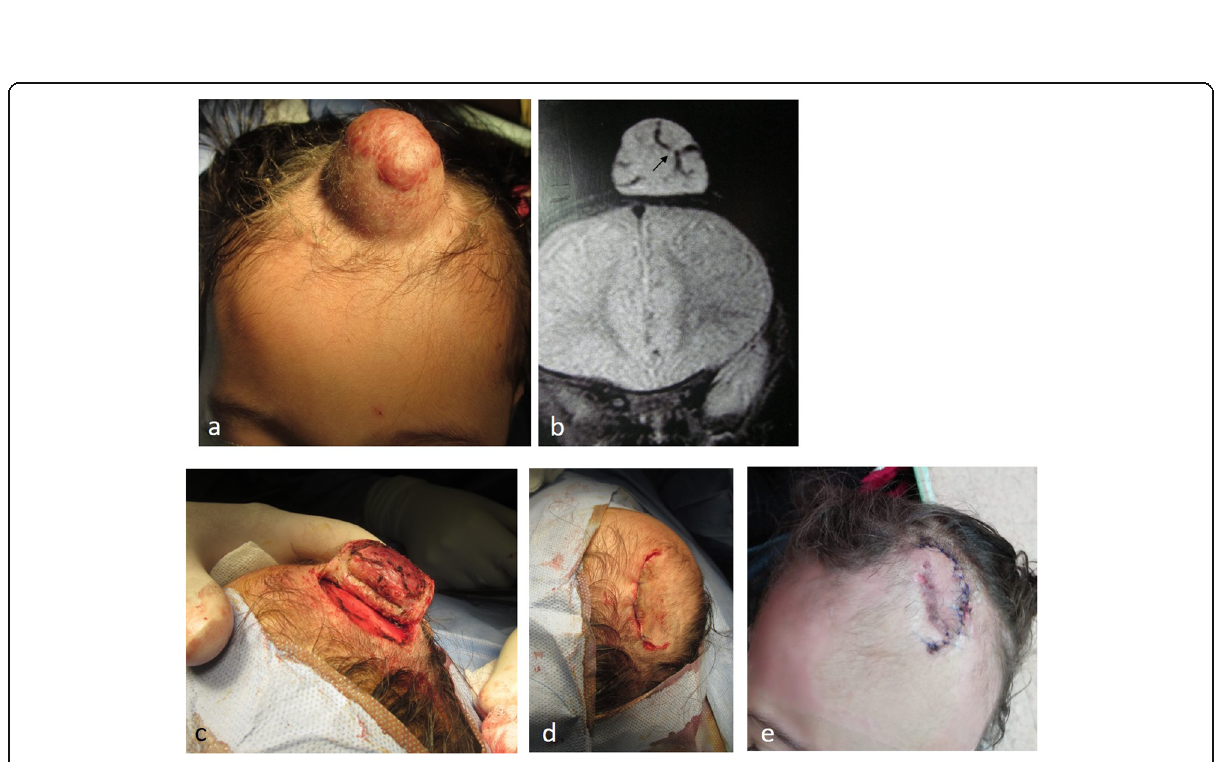
Fig. 3 a Infantile haemangioma of the scalp. b MRI showing typical hyperintense mass lesion with characteristic flow voids (black arrow). c , d , e Failure to respond to medical treatment (oral propranolol, intralesional steroid/bleomycin injection) was an indication for excision at the age of 3 years. Note: the overlying skin was not completely involved giving the chance of sparing a skin flap to be used to cover the skin defect after excision of the